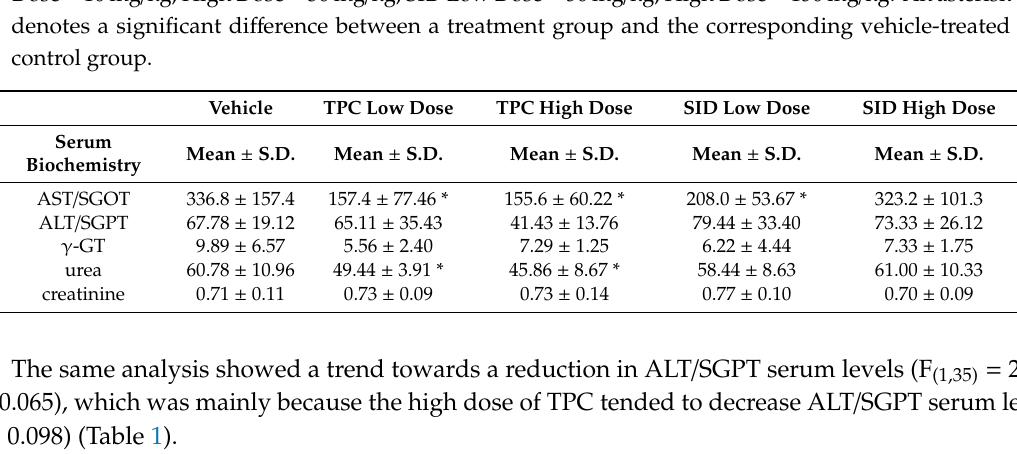
Table 1. Serum biochemistry. Serum biochemistry measurements for each treatment group. TPC